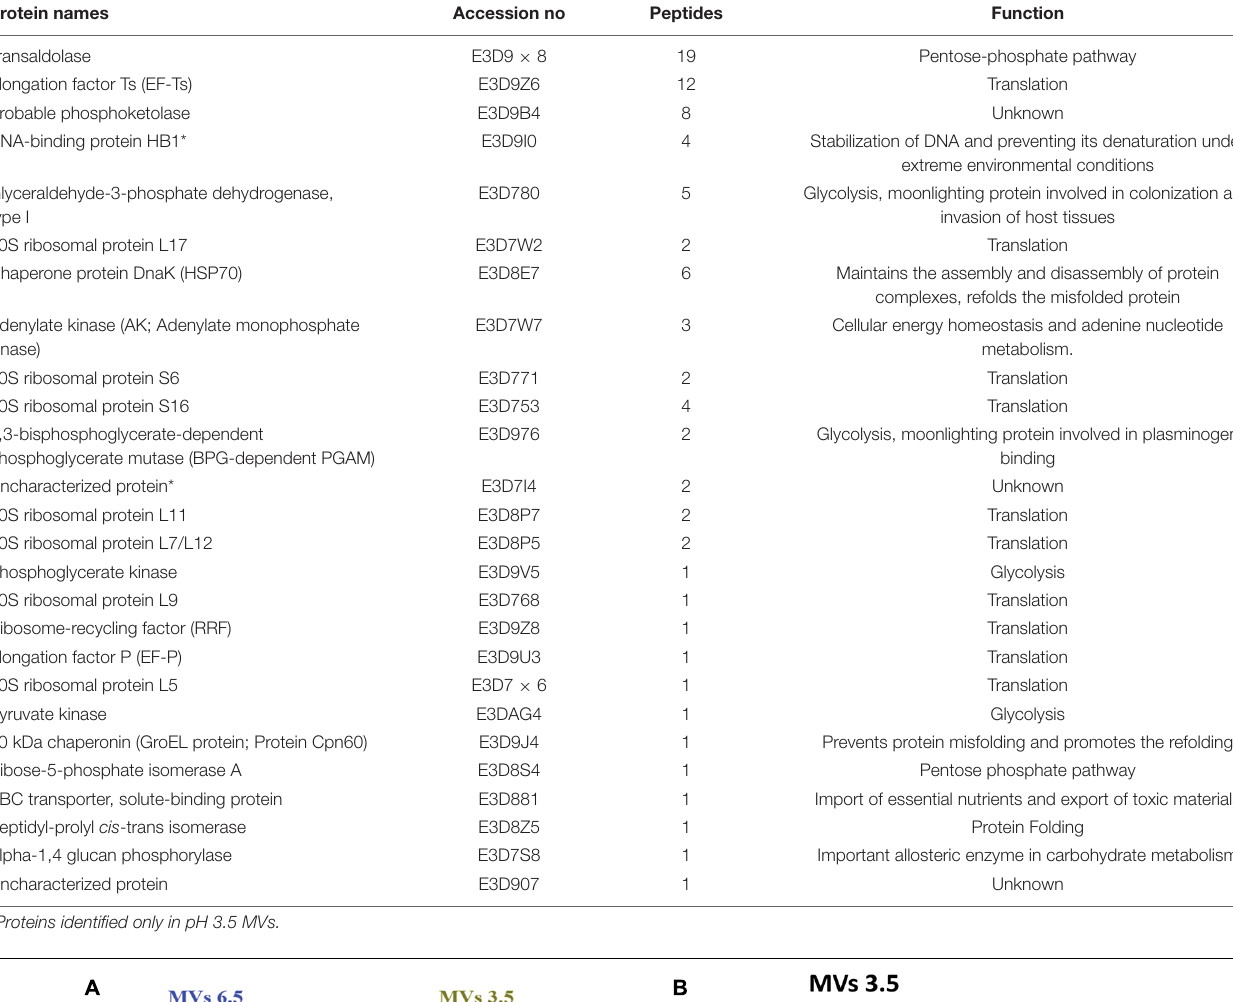
TABLE 1 | List of proteins identified in G. vaginalis MVs at pH 3.5.